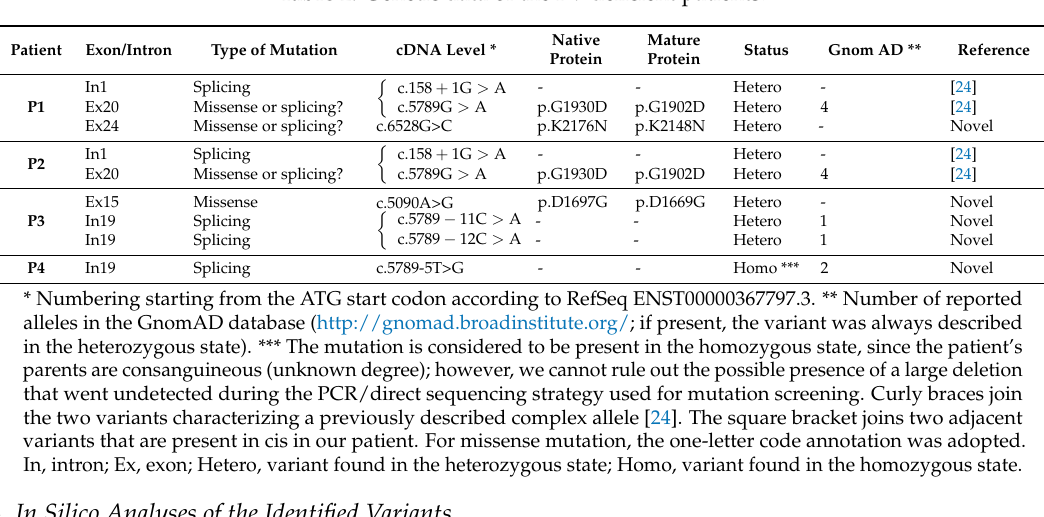
Table 2. Genetic data of the FV-deficient